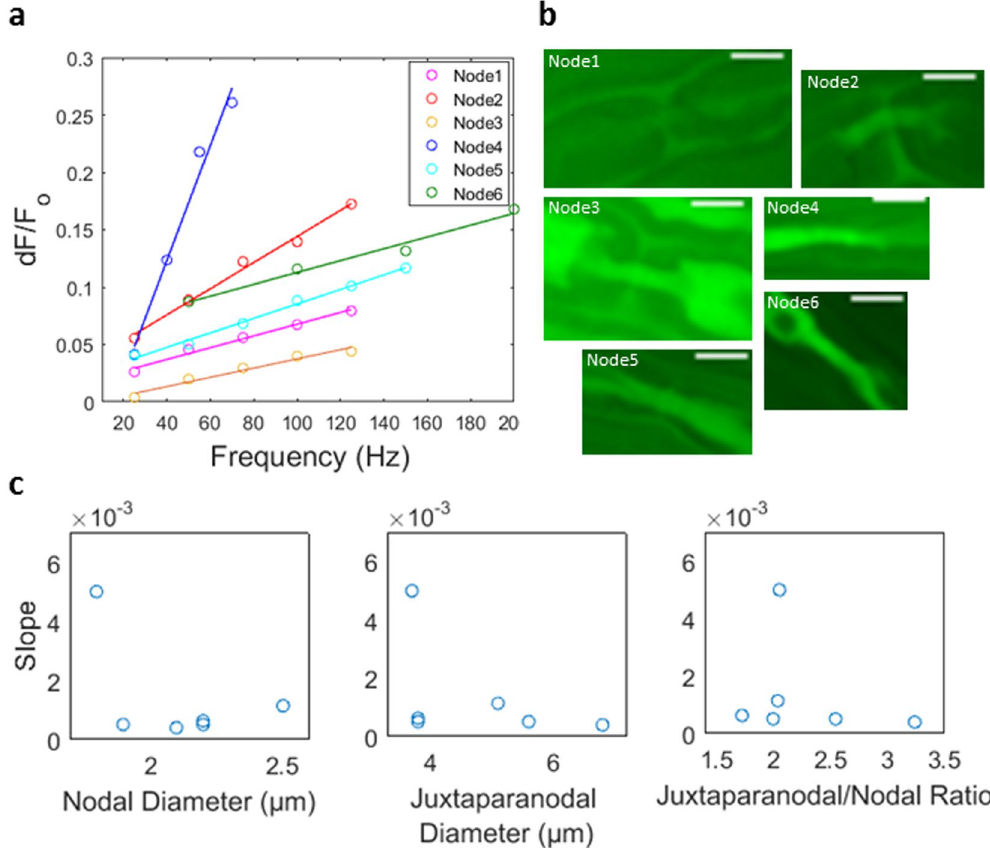
Figure 4. Comparison of frequency modulation slopes to nodal size ( a ) Frequency modulation slopes from nodes of six independent nerve sample. The nodal dF/F o vs. frequency traces are the ramp up and down (two sweep) means with the exception of Node4 and Node6 which are single sweep traces. ( b ) Images of each axon node (scale bar 5 μ m). ( c ) Slopes versus nodal diameter, juxtaparanodal diameter, and juxtaparanodal/nodal ratio do not reveal correlation between nodal size and